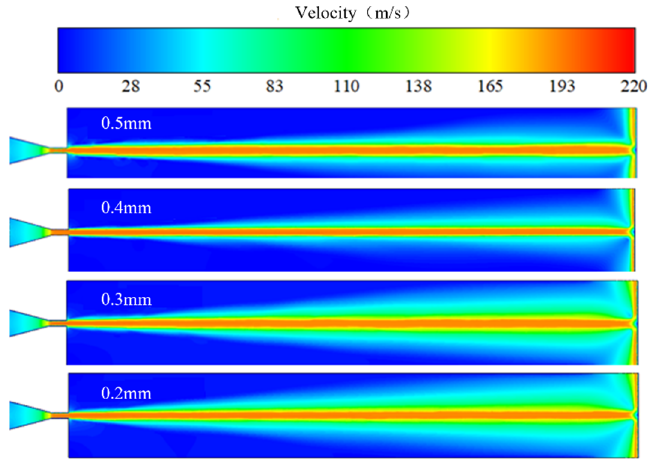
Figure 3. Velocity cloud of the flow field of different grid sizes.